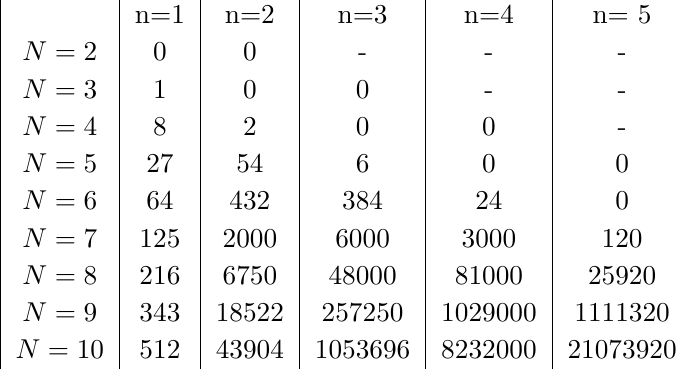
Table 1 . Evaluation of hO